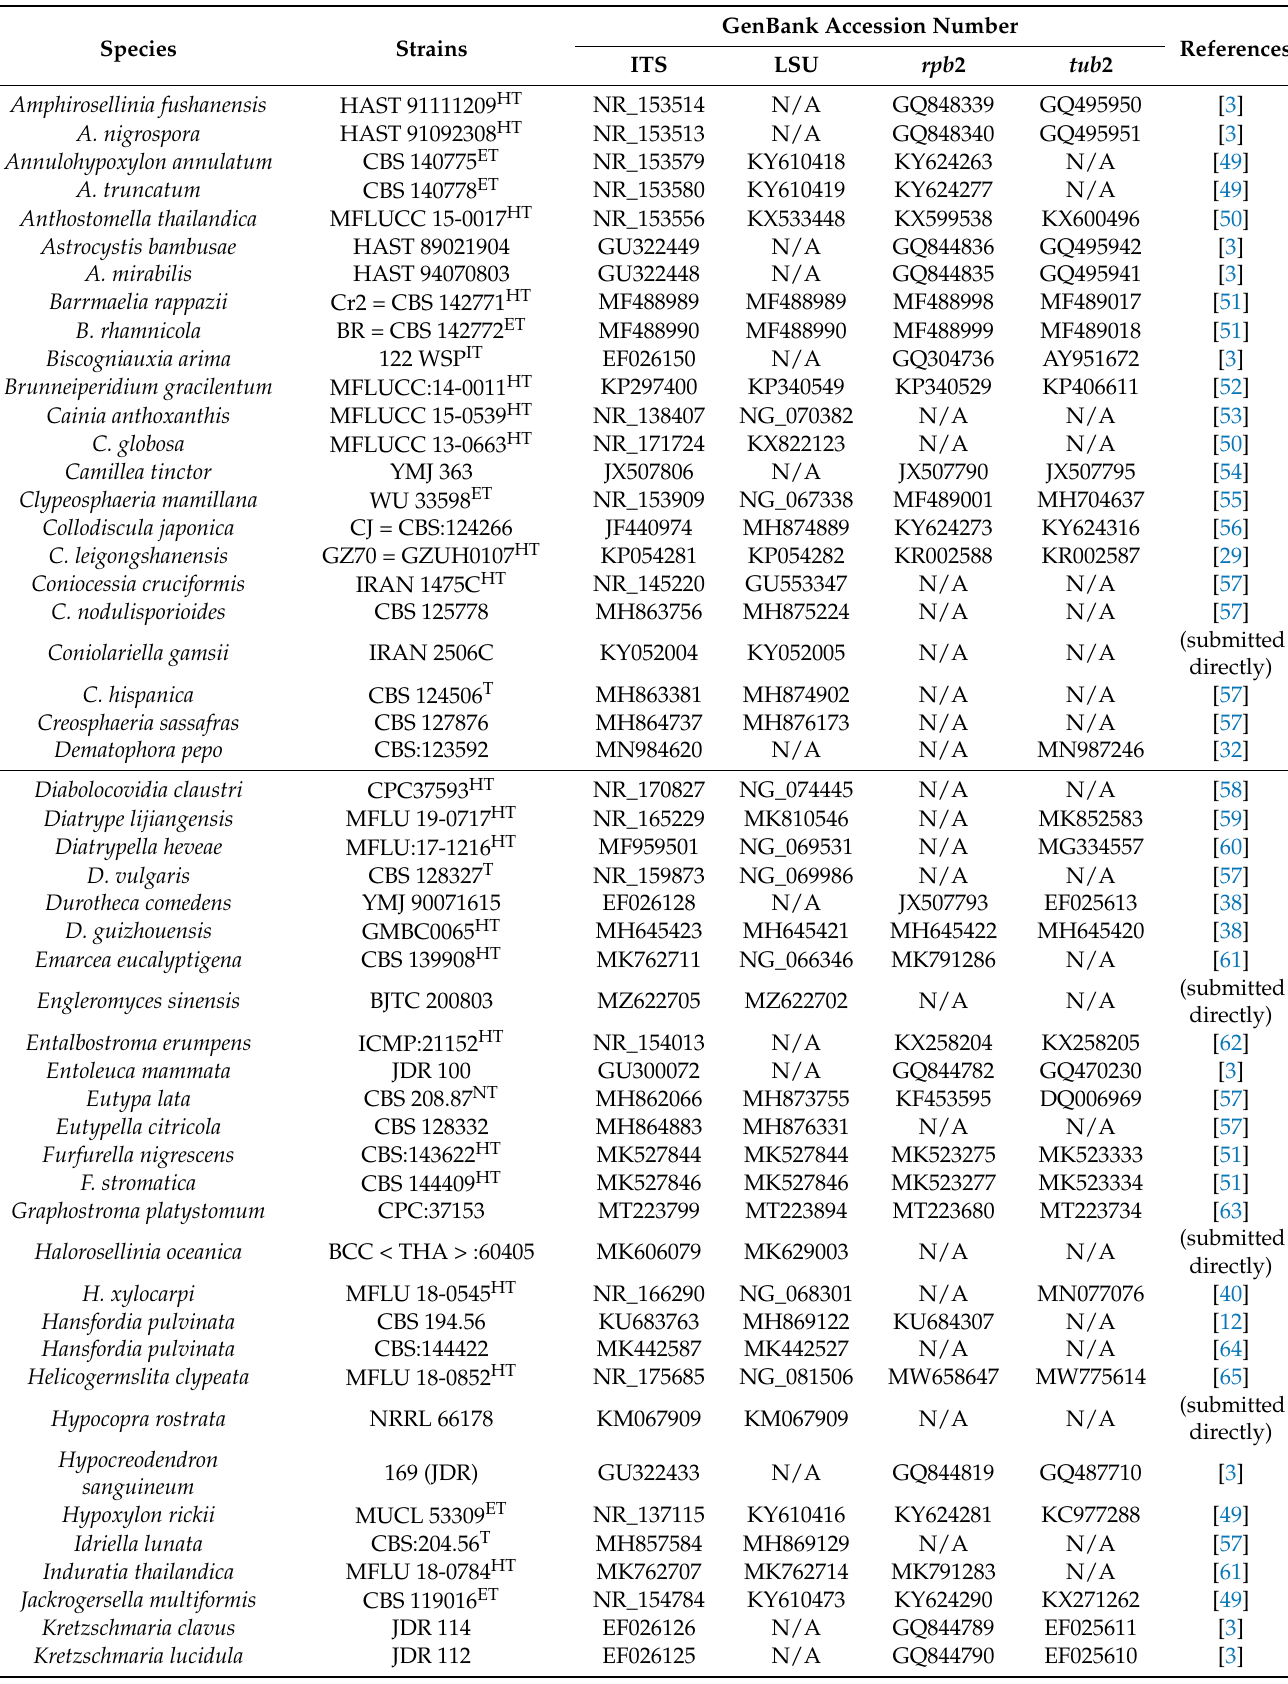
Table 1. List of taxa used for phylogenetic